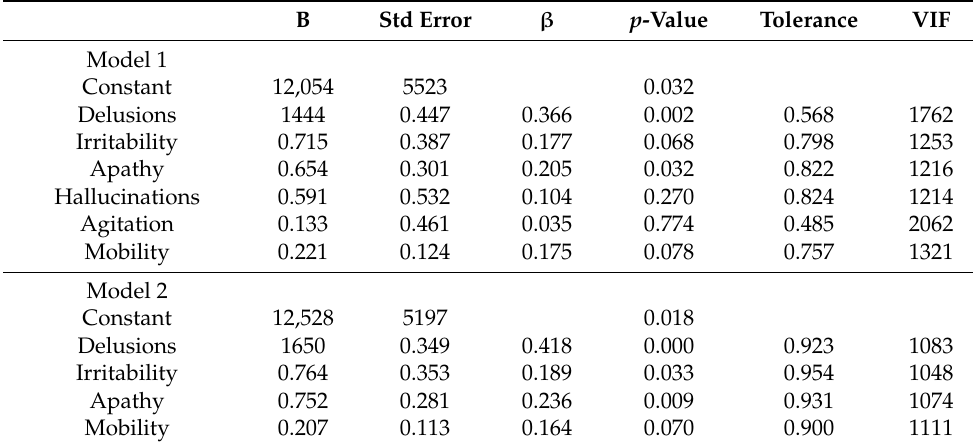
Table 3. Multiple regression lineal models for predicting